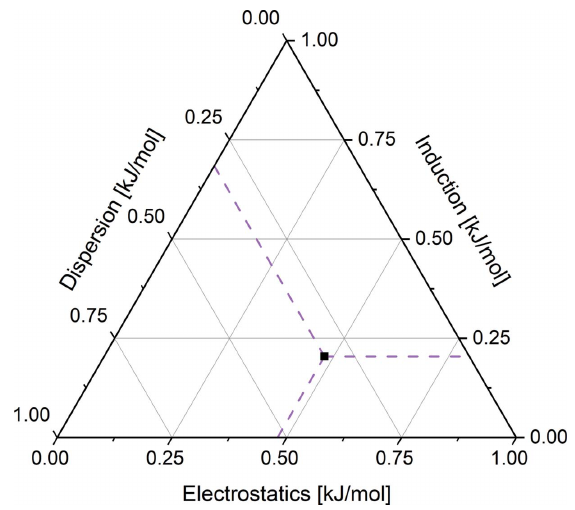
Figure 7 Ternary plot of the SAPT2+3 decomposition of the interaction energy between the Br 4 Q ring and two iodine